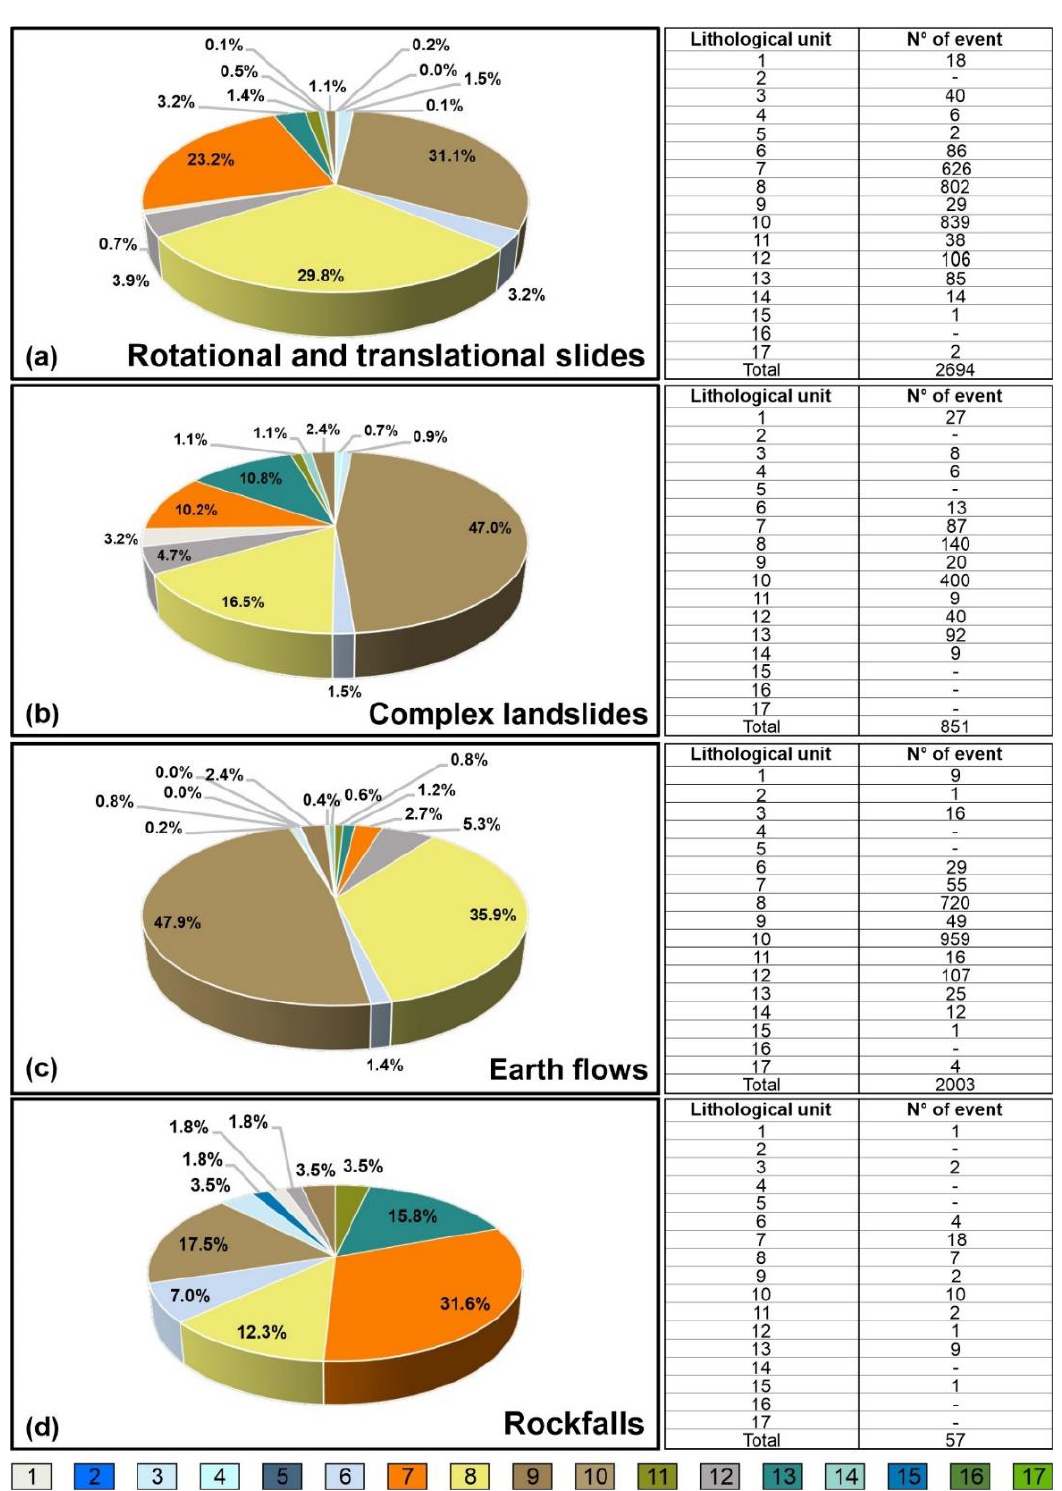
Figure 5. Relationships between lithological units and the distribution of different types of landslides in the Abruzzo hilly piedmont area. ( a ) Pie chart and table showing the percentage and number of rotational and translational slides on each lithological unit; ( b ) pie chart and table showing the percentage and number of complex landslides on each lithological unit; ( c ) pie chart and table showing the percentage and number of earth flows on each lithological unit; ( d ) pie chart and table showing the percentage and number of rockfalls on each lithological unit. Numbers and colors refer to legend in Table 1 and Figure 4.